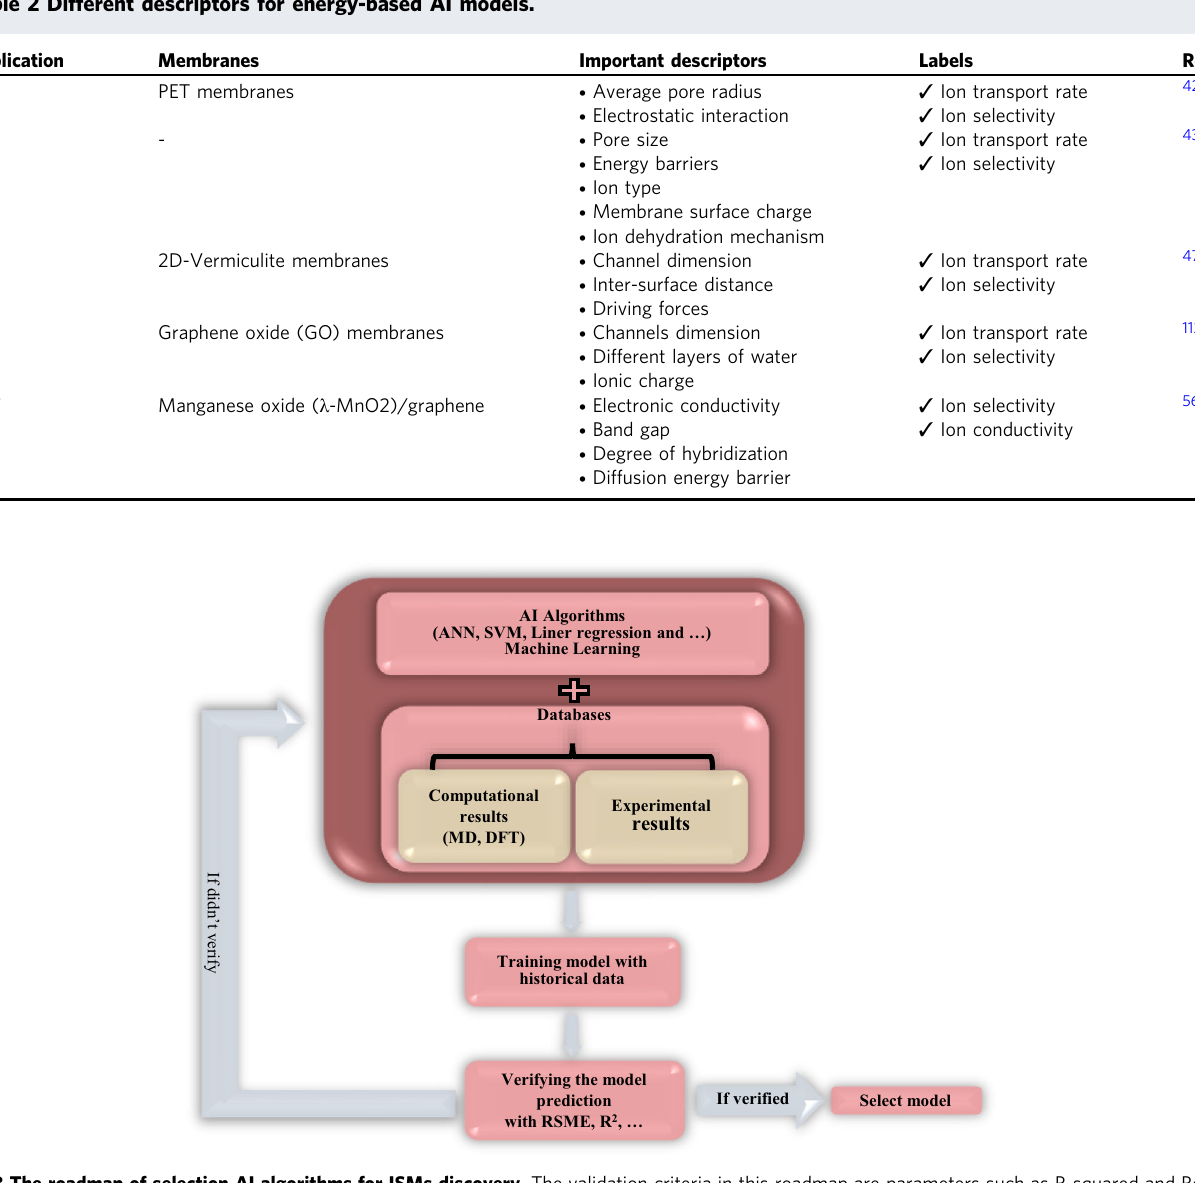
Fig. 3 The roadmap of selection AI algorithms for ISMs discovery. The validation criteria in this roadmap are parameters such as R-squared and Root- mean-square deviation (RMSE), which show the accuracy of the models. AI algorithms should be able to create models that have good accuracy based on experimental and computational datasets. Part of the dataset is used to train the model and part of it is used to test and validate the model. Validated models that have good accuracy can be used for ISMs